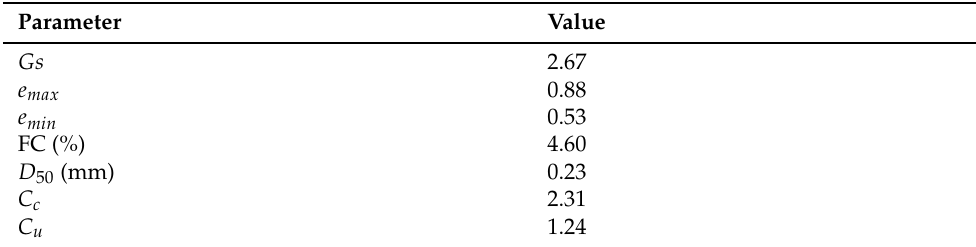
Table 2. Physical properties of the